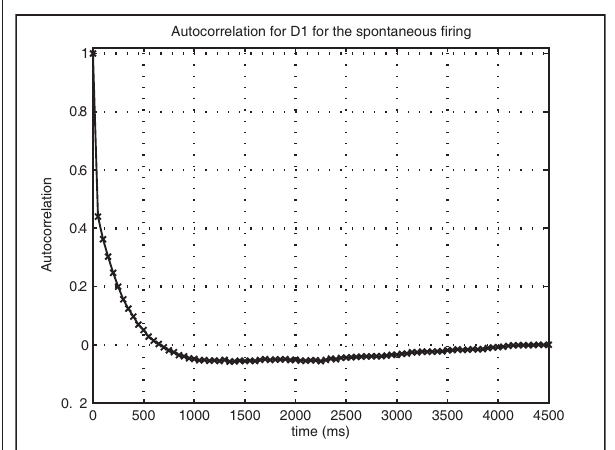
FIguRe 4 | Autocorrelation function for the spontaneous firing rate of the D1 population. The function was calculated from the mean firing rates of the population of neurons D1 calculated and sampled every 50 ms. To obtain 4.5 s of data, the decision cues were omitted from these simulations. Data were used from 930 trials in which the spontaneous firing rate remained stable and below 5 spikes/s at the end of the 6-s trial (and this was all but seven of the trials as the network contained 4000 neurons and the spontaneous state was quite stable). The data were from bins each 50 ms in duration starting 1000 ms after the start of the 6-s simulation, and the average autocorrelation function computed over the 930 trials is shown. The negative values of the autocorrelation function at lags of greater than 700 ms just reflects the setting of the average value of the time series to a mean of zero, with the actual autocorrelation being zero at lags of greater than 700